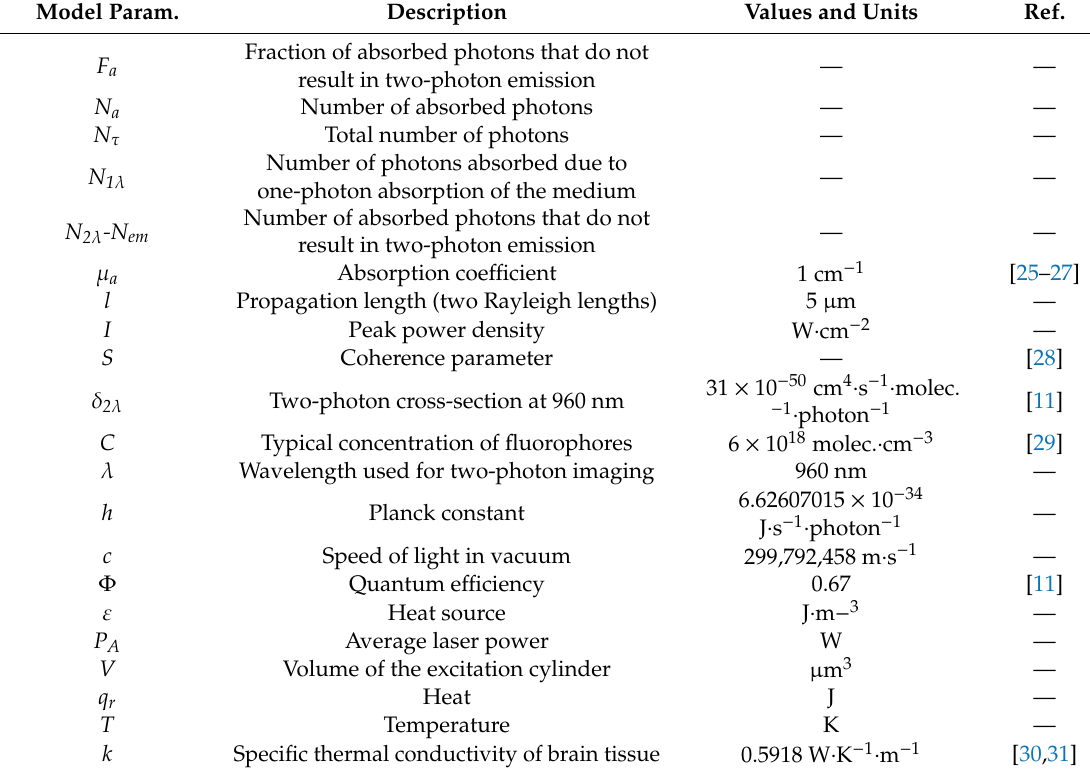
Table 1. Modeling parameters and